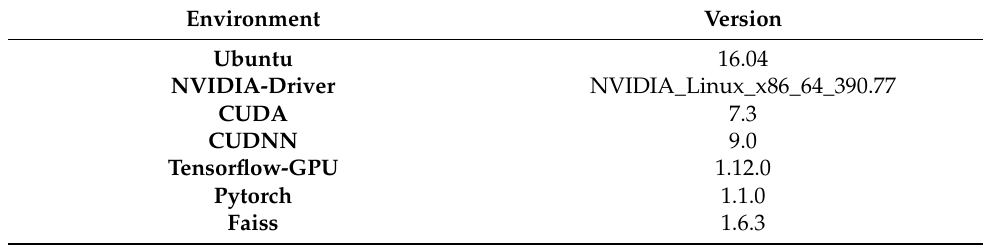
Table 3. Information of